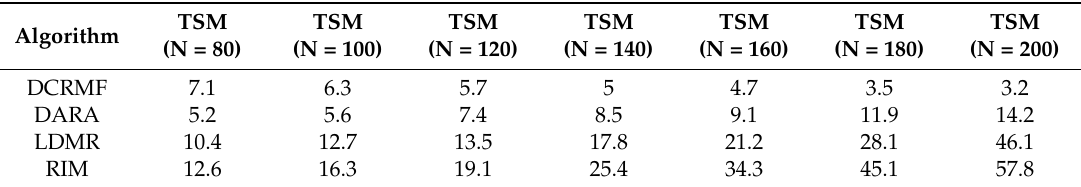
Figure 10. The relationship between the total sending messages and the number of nodes in the network by using these four algorithms. Table 5. Comparison of different methods on the change of average number of total sending messages with the numbers of nodes varying.